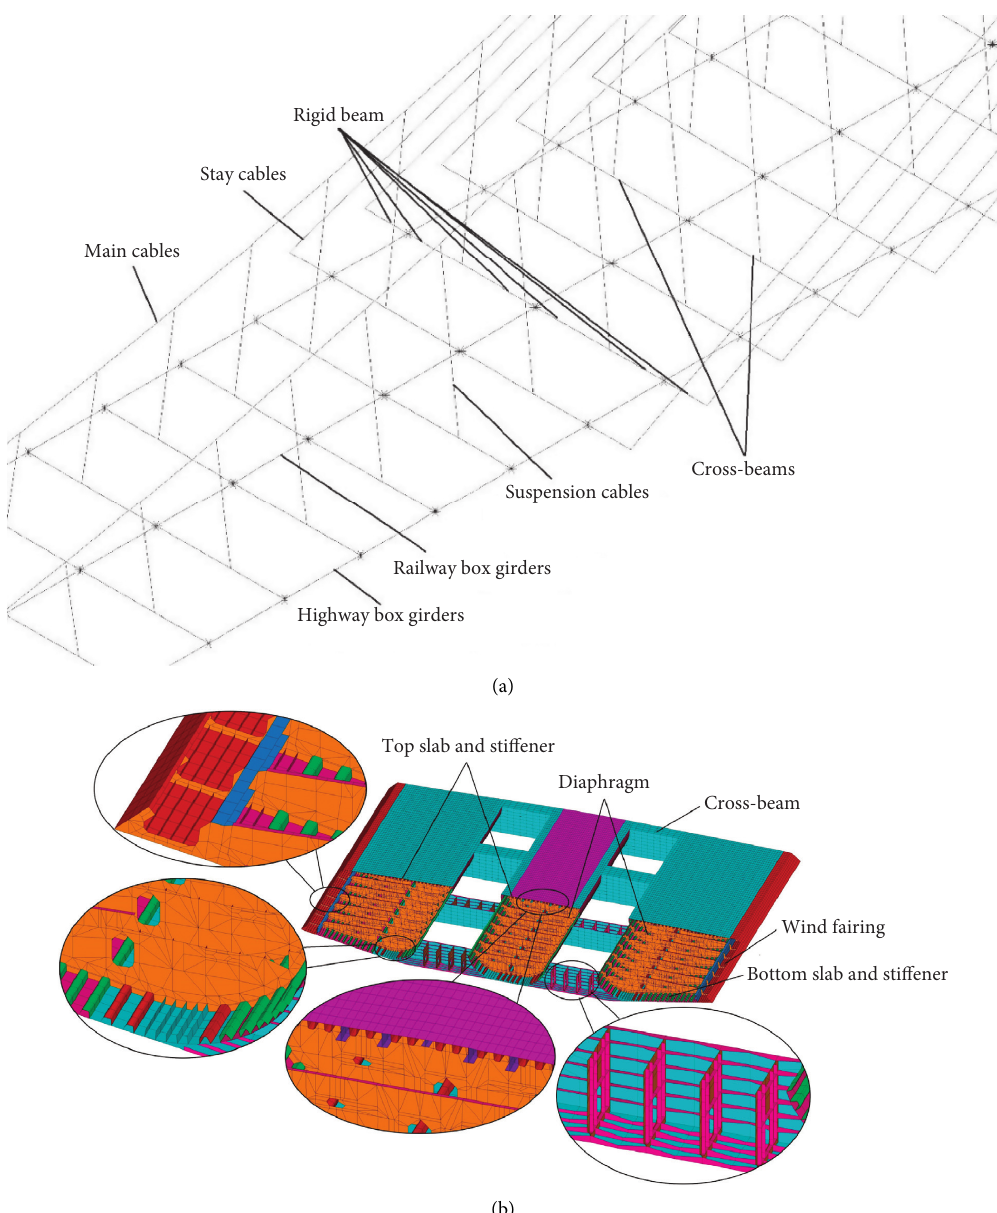
Figure 3: Local construction diagram. (a) IBEM. (b)